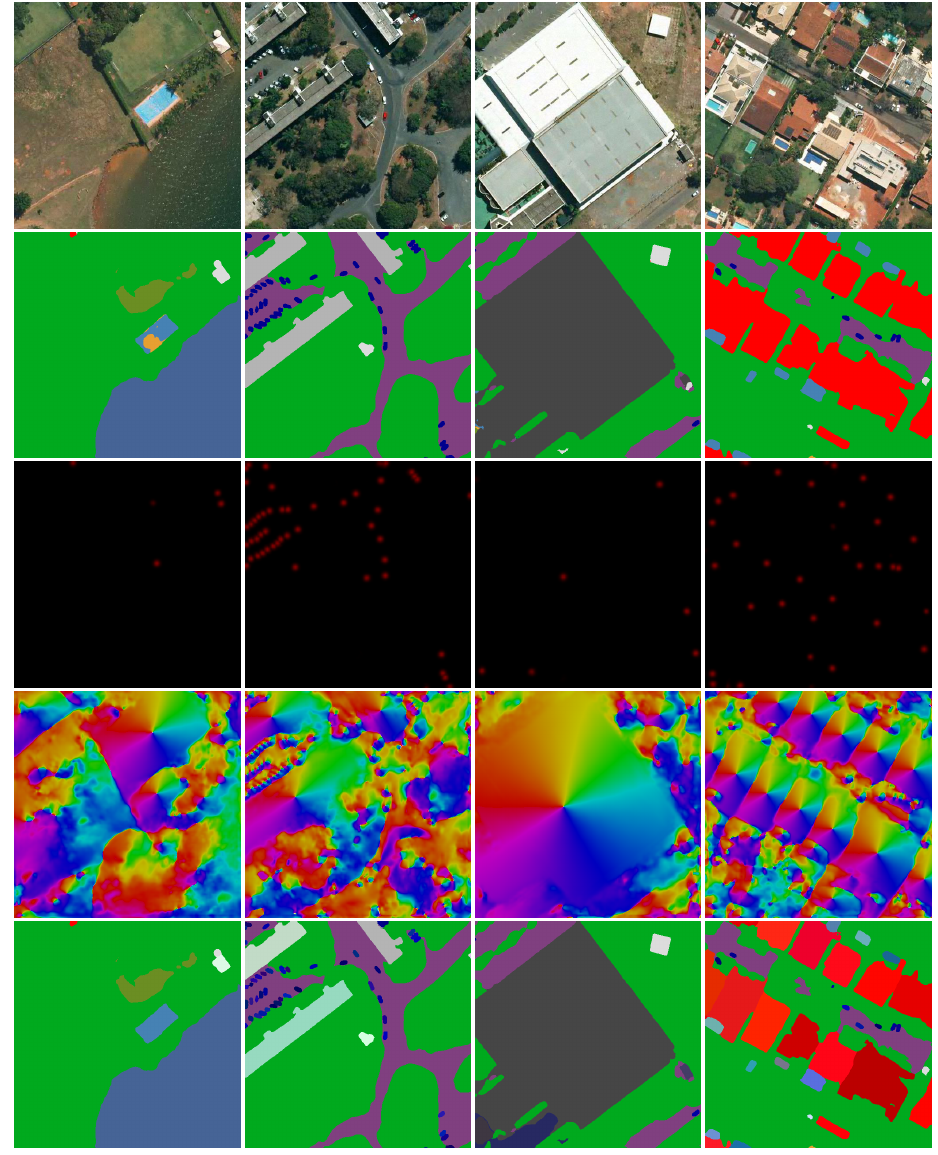
Figure 3. Qualitative results on four scenes from BSB val. Rows show: (first) input image, (sec- ond) semantic segmentation, (third) centers heatmap, (fourth) offset directions, and (fifth) panoptic